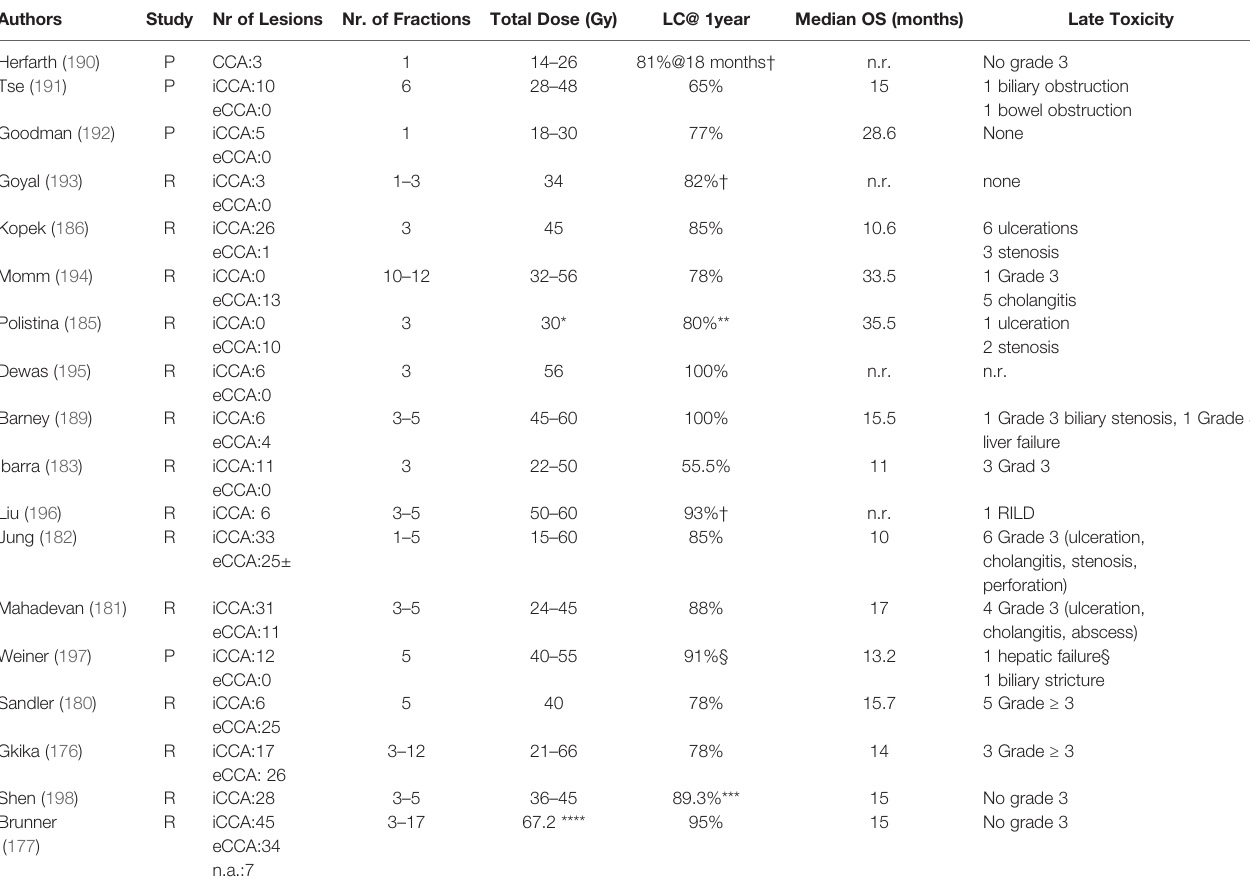
TABLE 6 | SBRT in the treatment of cholangiocarcinoma. Authors Study Nr of Lesions Nr. of Fractions Total Dose